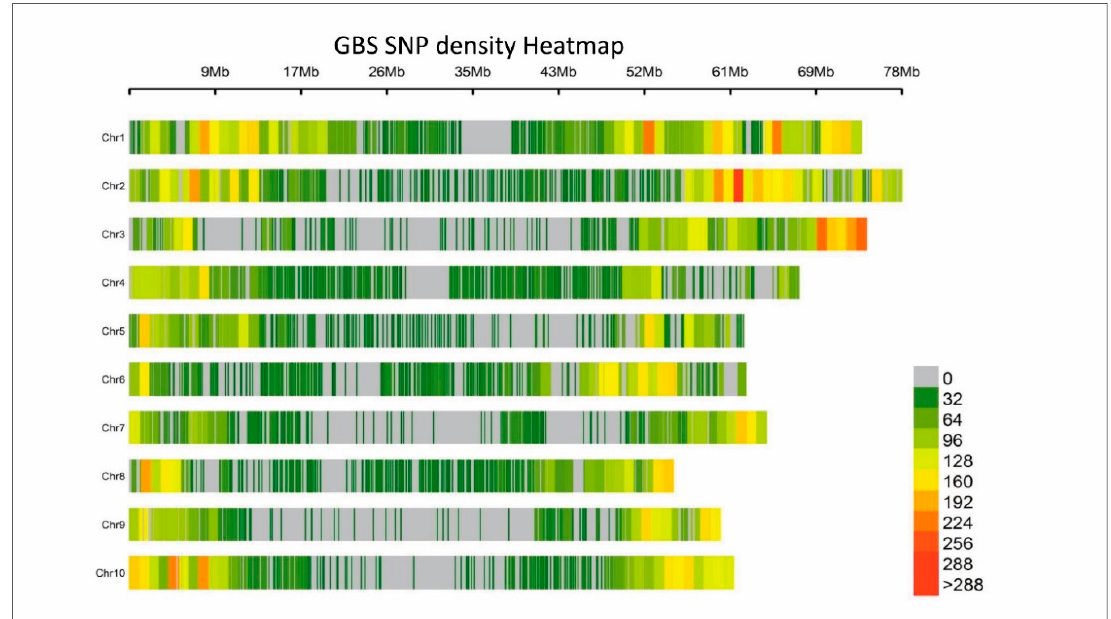
Figure 2. GBS–SNP density for cross RSG04008-6 / J2614-11 developed for the stay-green QTL fine-mapping on SBI-10L. Genome-wide distribution of 29,506 SNPs represented in the color coded bars for the cross RSG04008-6 / J2614-11 represented in 1 Mb window size. Green color sections across chromosome indicate low SNP density to red, being > 288 SNPs per 1 Mb window size. Average SNP density ( > 150 SNP / Mb indicated by yellow color) was present in the telomeric regions.